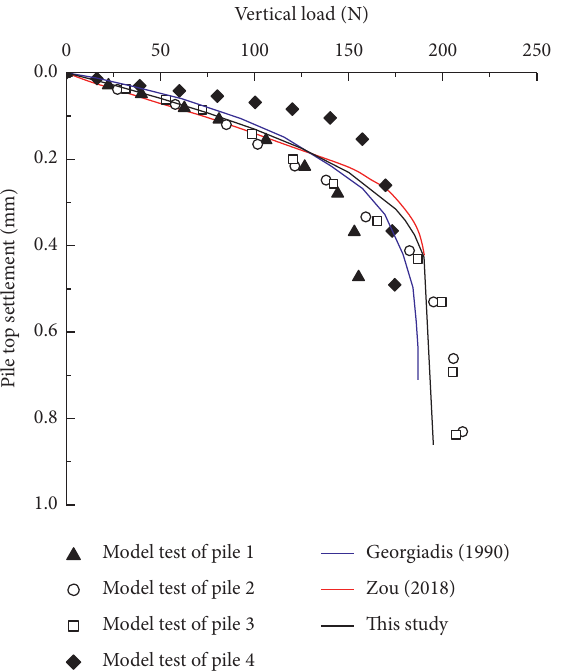
pile top under the T ⟶ V loading